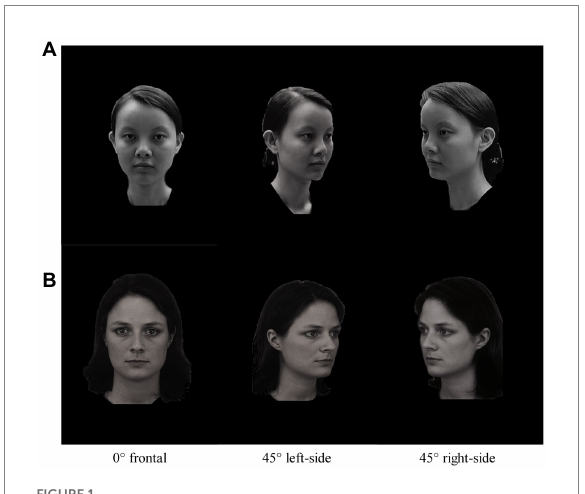
FIGURE 1 Examples of the stimuli showing three gaze directions. (A) Model CF1 from CAS-PEAL (Chinese Academy of Sciences pose, expression, accessory, and lighting; Gao et al., 2008). (B) Model FF1 from KDEF (The Karolinska Directed Emotional Faces; Lundqvist et al.,